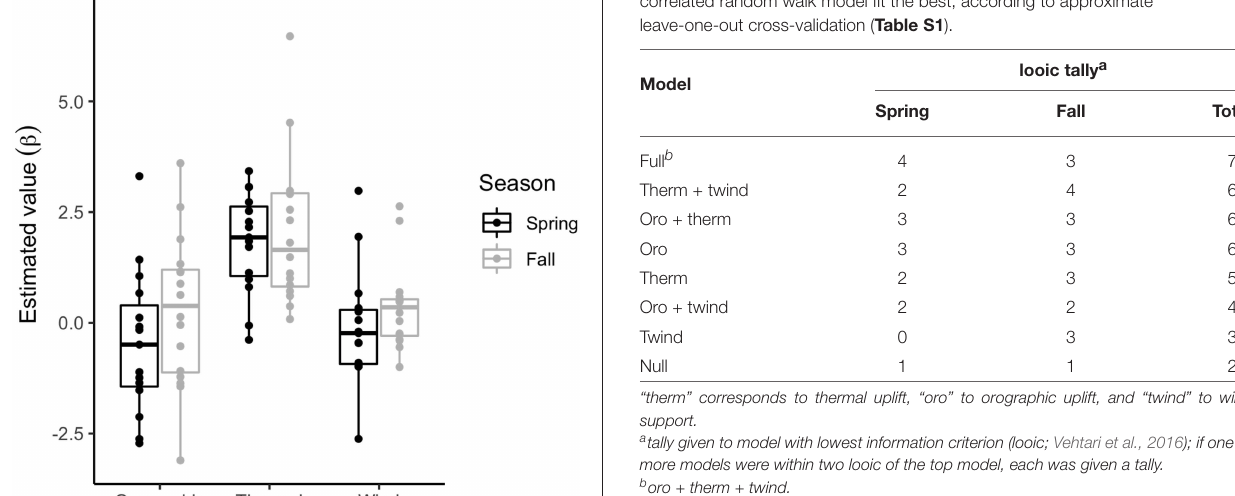
TABLE 2 | Number of golden eagle migration tracks recorded by GPS transmitters that each candidate formulation of the behavioral process in the